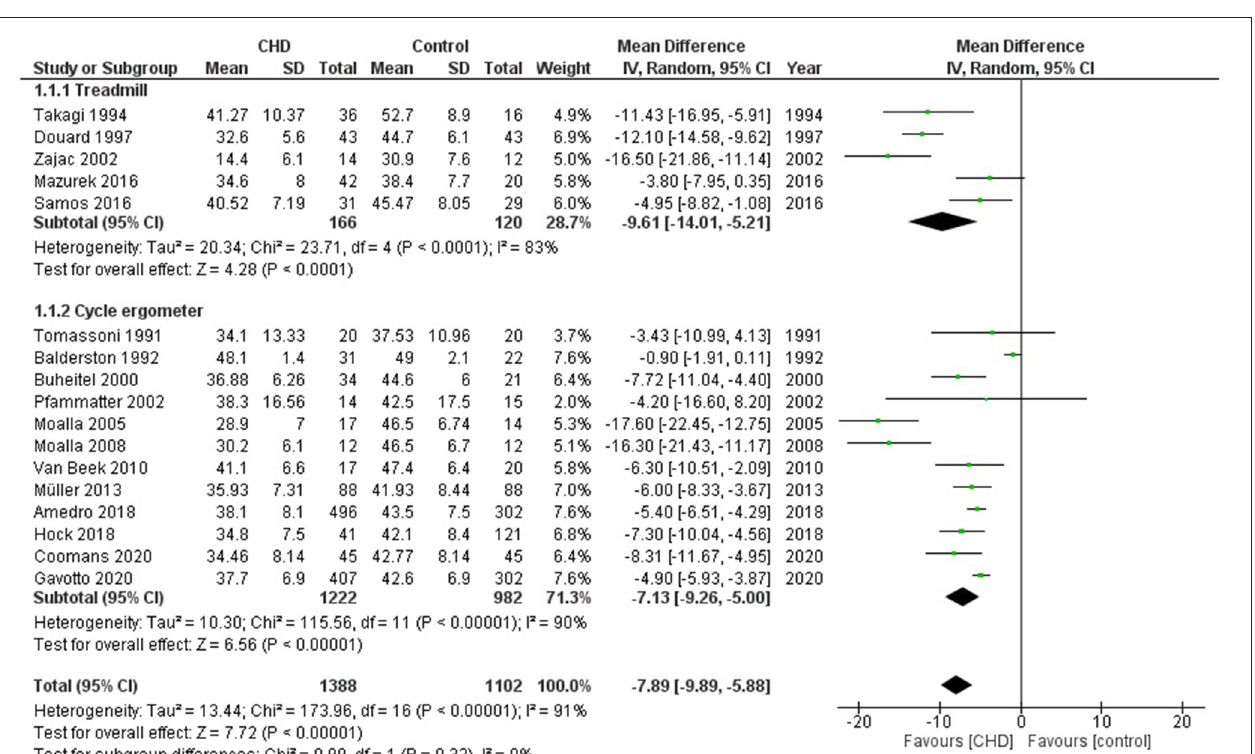
O 2 pulse compared with controls ( p < 0.00001, I 2 = 6%) ( Supplementary File 2 , Figure 4